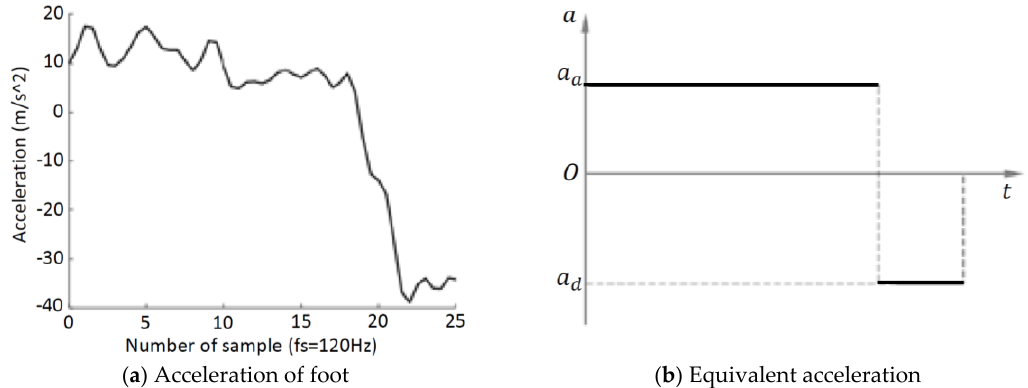
Figure 5. Acceleration of the swing foot during quasi-period gait.